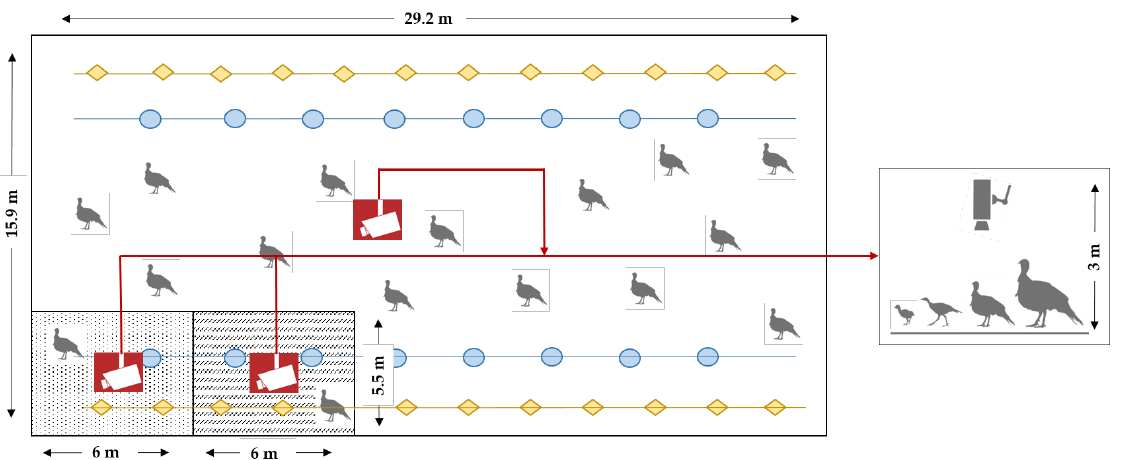
Figure 1. Schematic view of the turkey barn (15.9 × 29.2 m) showing the different positions of the three top-view video cameras. The feeding lines are shown with orange squares, and the drinking lines have blue circles. A separate experimental compartment (5.5 × 6 m) and a second compartment (5.5 × 6 m) for sick animals are shown as differently patterned